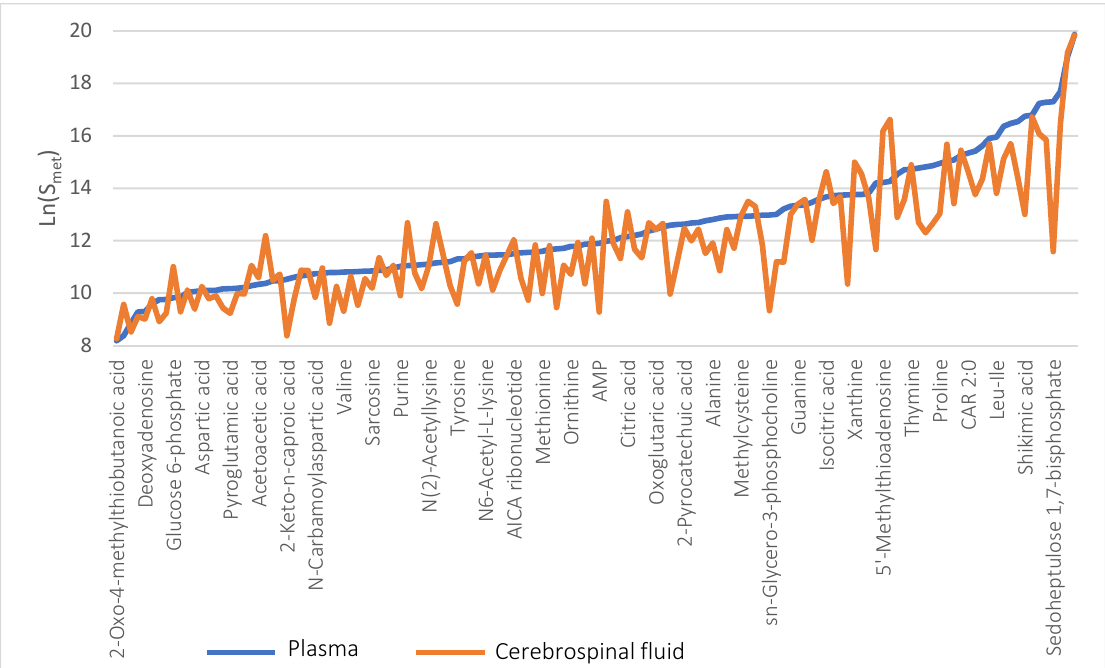
Figure 2. Correlation (R = 0.85) between CSF and plasma metabolite profiles in a combined group of glioma patients and healthy controls. Each point corresponds to an individual metabolite. Ln values of the average peak area of a metabolite in plasma (S PL , axis X) and CSF (S CSF , axis Y) are shown, respectively.